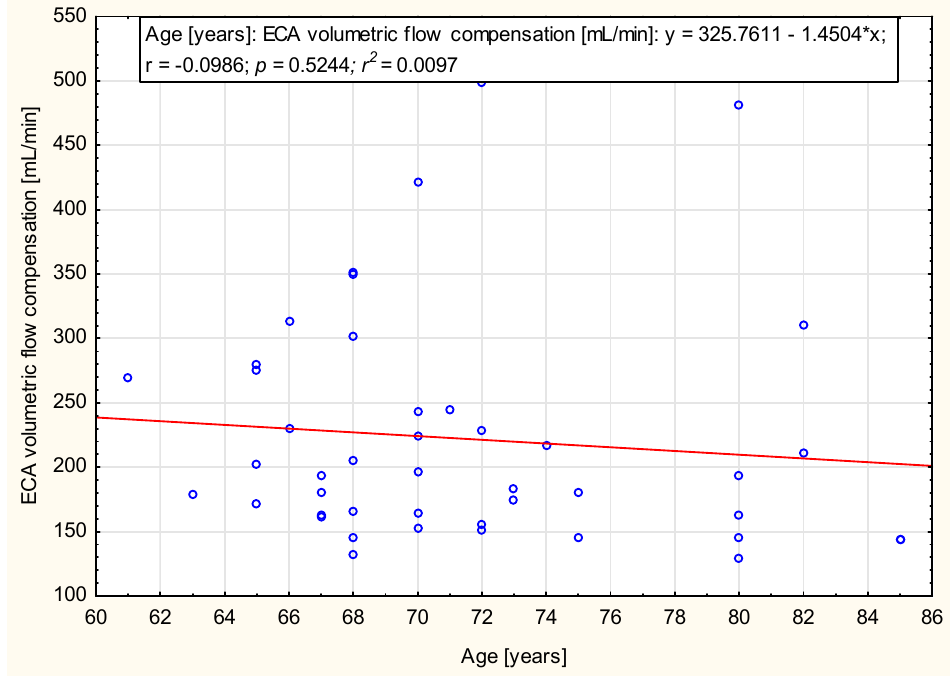
Figure 6. Scatter plot of the volumetric flow compensation in ECA and age (y = 325.7611 − 1.45048*x). No correlation was observed ( p = 0.52).